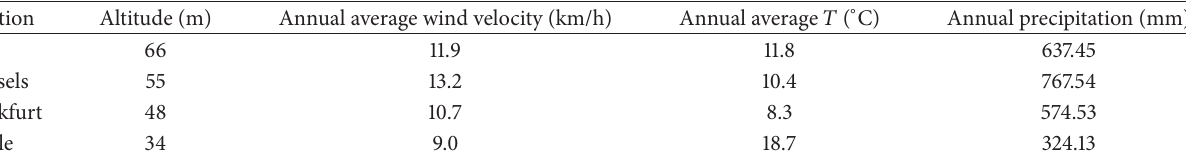
Table 2: Weather conditions in the different locations in 2012 [23].